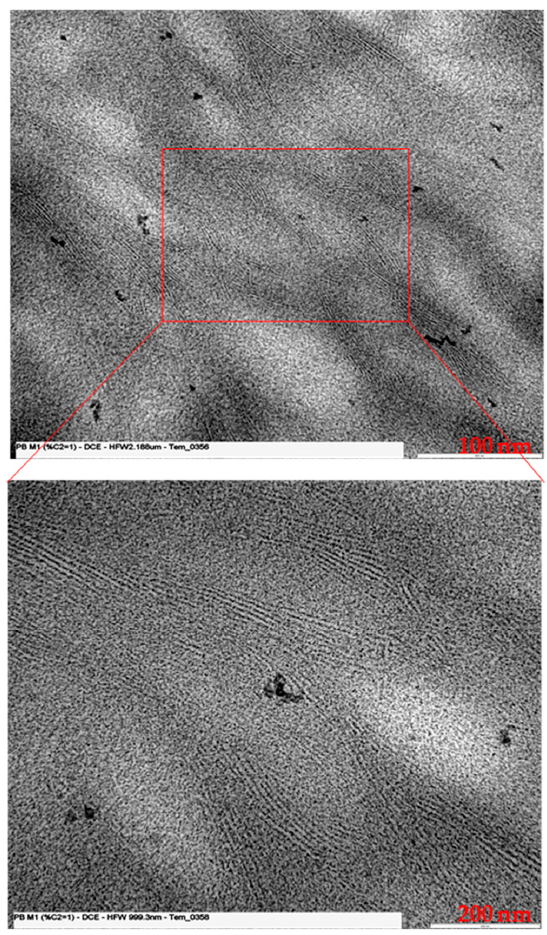
Figure 9. TEM image of PB1 at different magnification